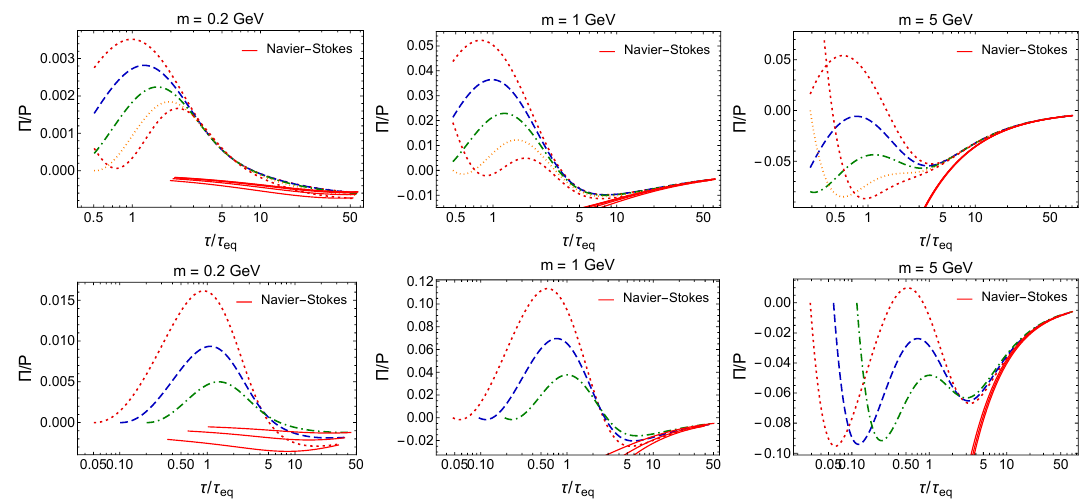
Figure 9 . Scaled bulk viscous correction Π /P from eq. (2.33) as a function of rescaled time τ/τ eq . The rows and columns are the same as in figure 8. The non-solid curves are specific runs and the solid curve shows the first-order Navier-Stokes prediction given in eq. (3.13).